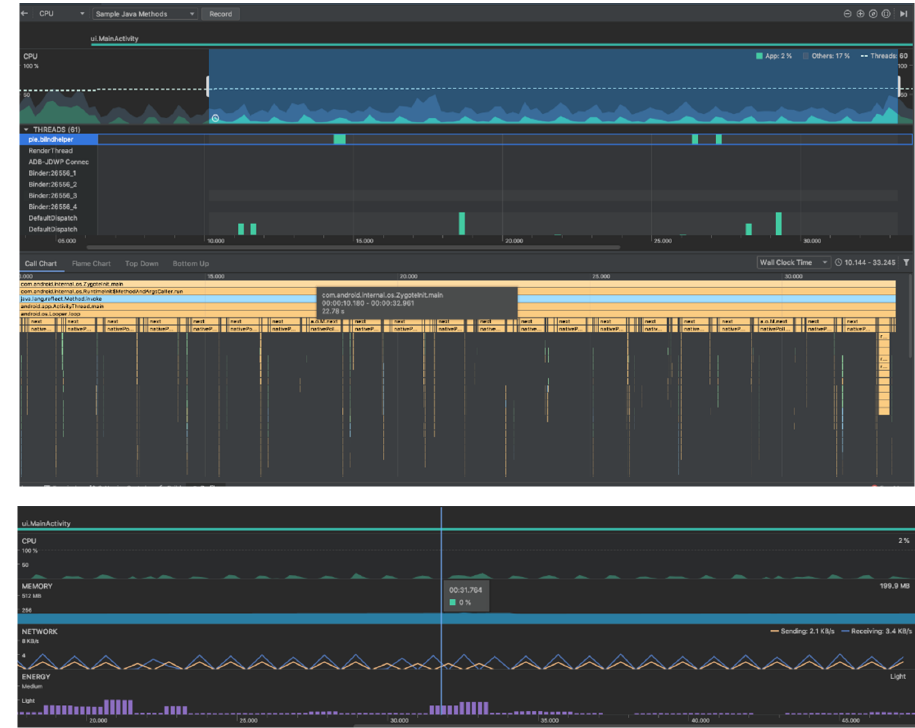
Figure 14. 2 × 2 Kalman filter CPU, memory and power load.